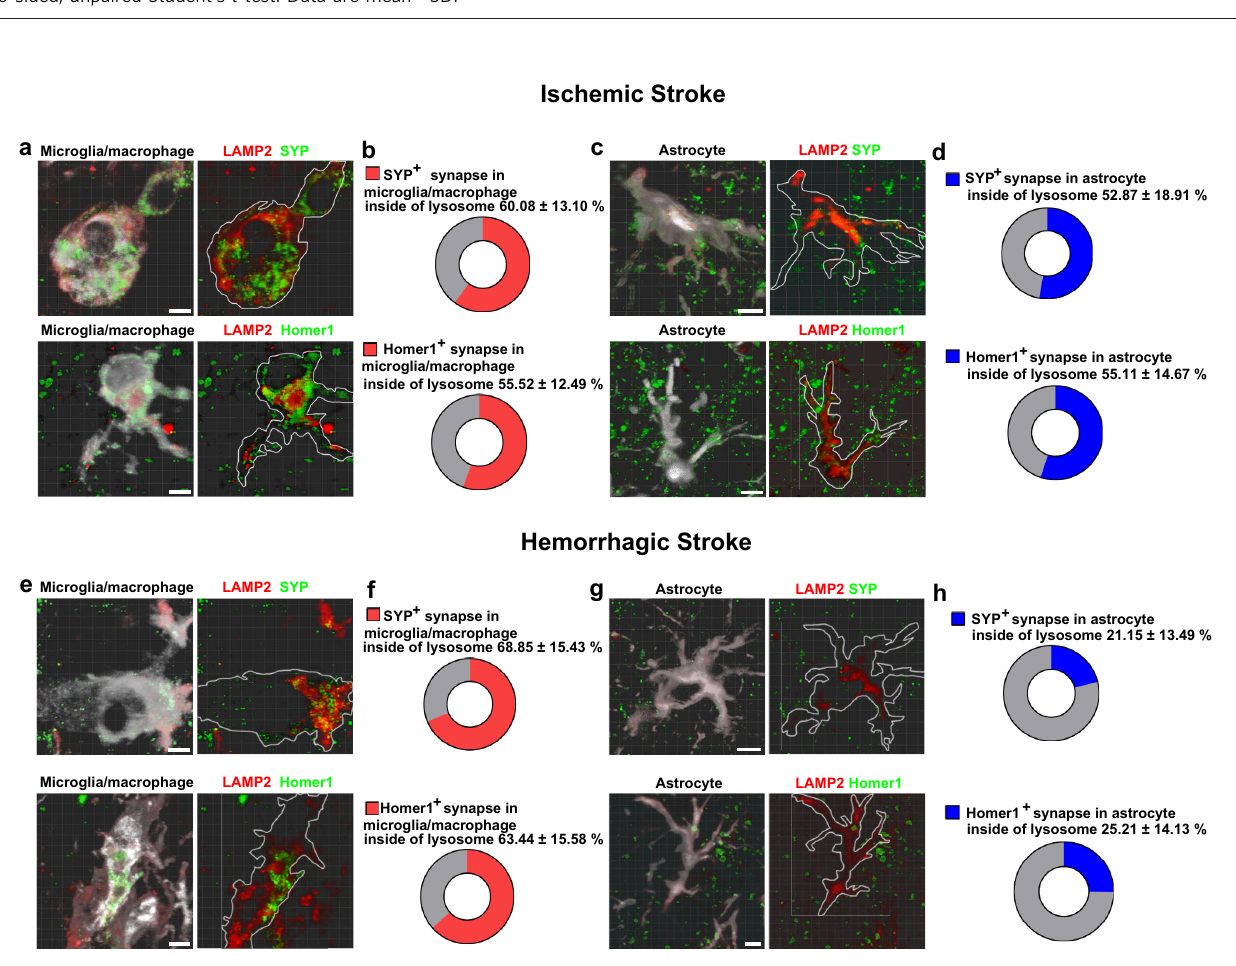
Fig. 2 Microglia/macrophages and astrocytes engulfed both excitatory and inhibitory synapses in stroke mice. Colocalization assays showed microglia/ macrophages ( a , Iba-1 + , white) and astrocytes ( d , GFAP + , white) engulfed excitatory postsynaptic and inhibitory postsynaptic elements in the gliosis region at 14 days after MCAO. Arrows indicate mCherry-alone puncta within microglia/macrophages or astrocytes. Quanti fi cation comparing the volume of mCherry-alone synapses inside microglia/macrophages ( b ) or astrocytes ( e ). b , e Statistics are derived from 11 slices, n = 4 mice per group. Quanti fi cation showing the percentage of synaptic puncta inside/outside microglia/macrophages ( c ) or astrocytes ( f ) in the ischemic brain. Colocalization images showed mCherry-alone puncta within microglia/macrophages ( g , white) or astrocytes ( j , white) in the hemorrhagic brain. Quanti fi cation comparing the volume of mCherry-alone synapses inside microglia/macrophages ( h ) or astrocytes ( k ). Statistics are derived from 15, 12 slices ( h ) and 10, 10 slices ( k ) (from left to right), n = 4 mice per group. Quanti fi cation showing the percentage of synaptic puncta inside/outside microglia/macrophages ( i ) or astrocytes ( l ) in the hemorrhagic brain. Scale bar = 10 µ m. ExPost excitatory postsynapse, InhiPost inhibitory postsynapse. AU arbitrary units. b , e , h , k , two-sided, unpaired Student ’ s t test. Data are mean ± SD.